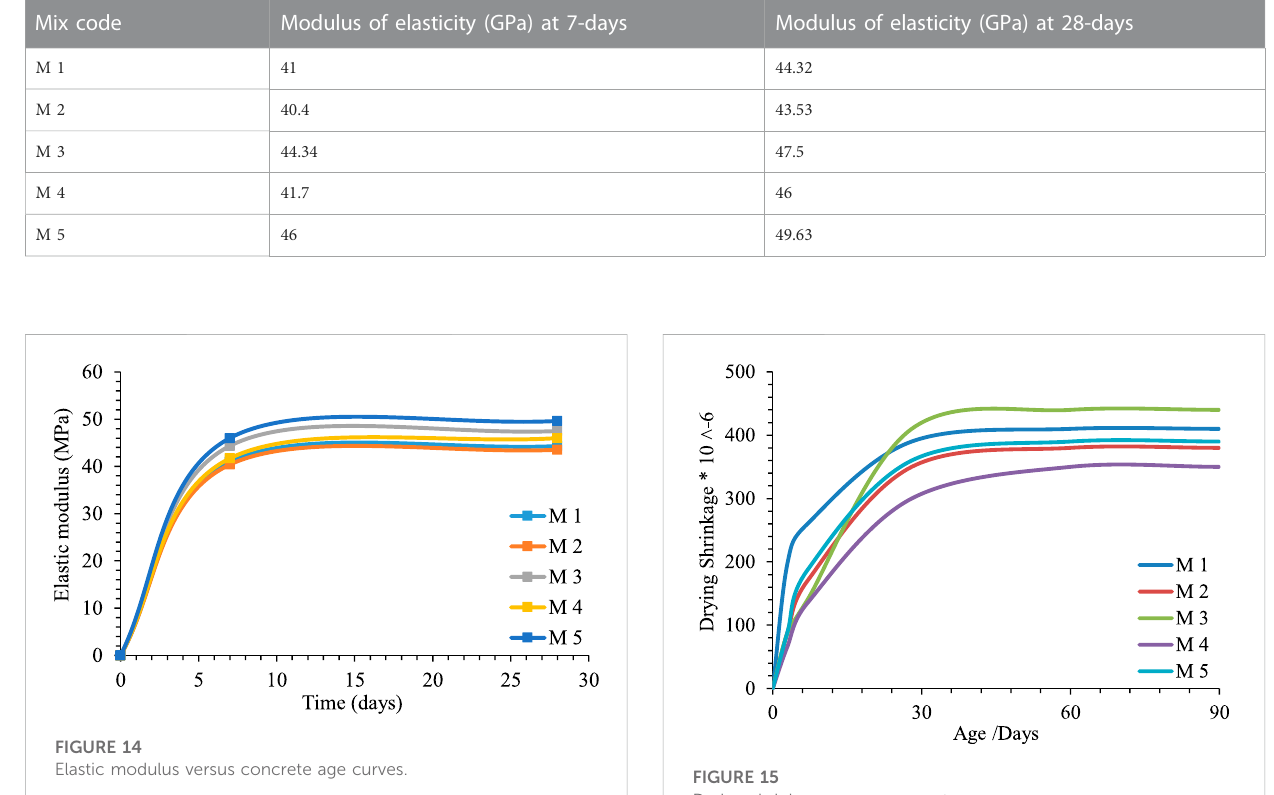
Drying shrinkage versus concrete age